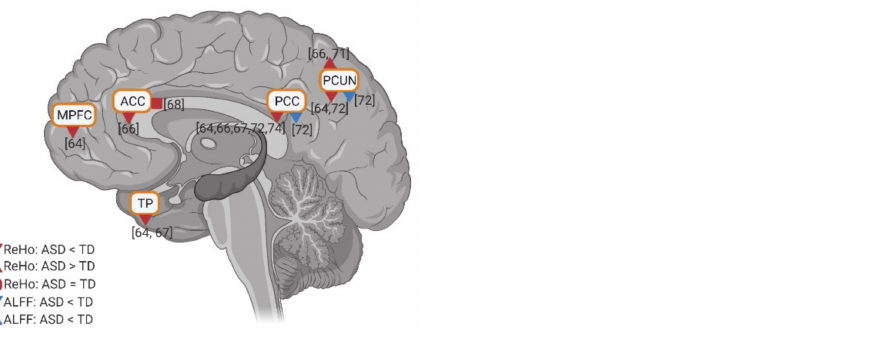
Figure 6. Intraregional resting state activity (ALFF and REHO) in DMN for individuals with ASD compared to TD. The numbers in the figure correspond to the study numbers in Table